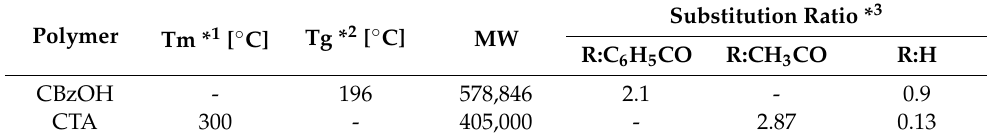
Figure 1. Chemical structure of the cellulose derivatives. CBzOH and CTA were used in this study with R groups which are listed in Table 1 [26]. Table 1. Properties of the used.